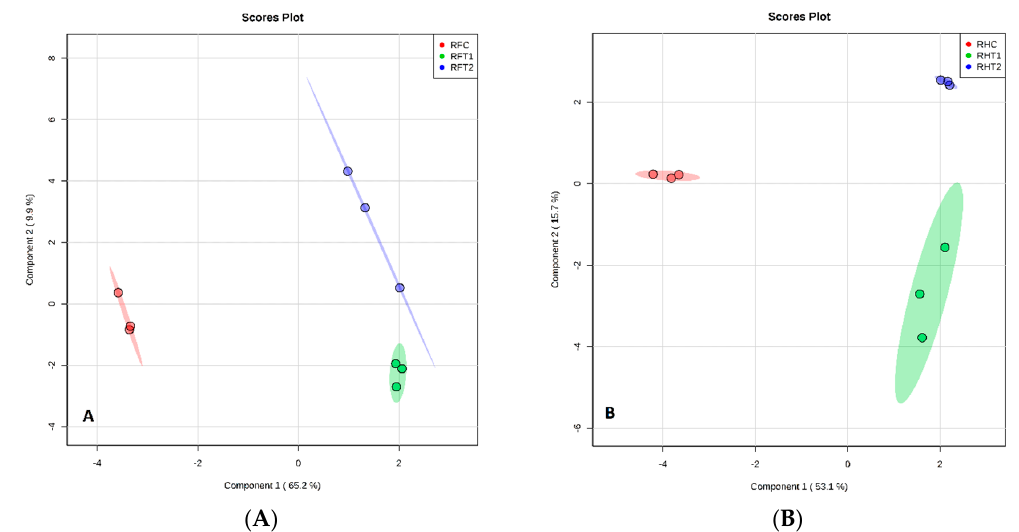
F represents Floribunda, H represents Hybrid Tea. While C represents control, T1 and T2 represent 100 and 200 mg/L BA, respectively. Three dots in each group mean n = 3 biological replicates.